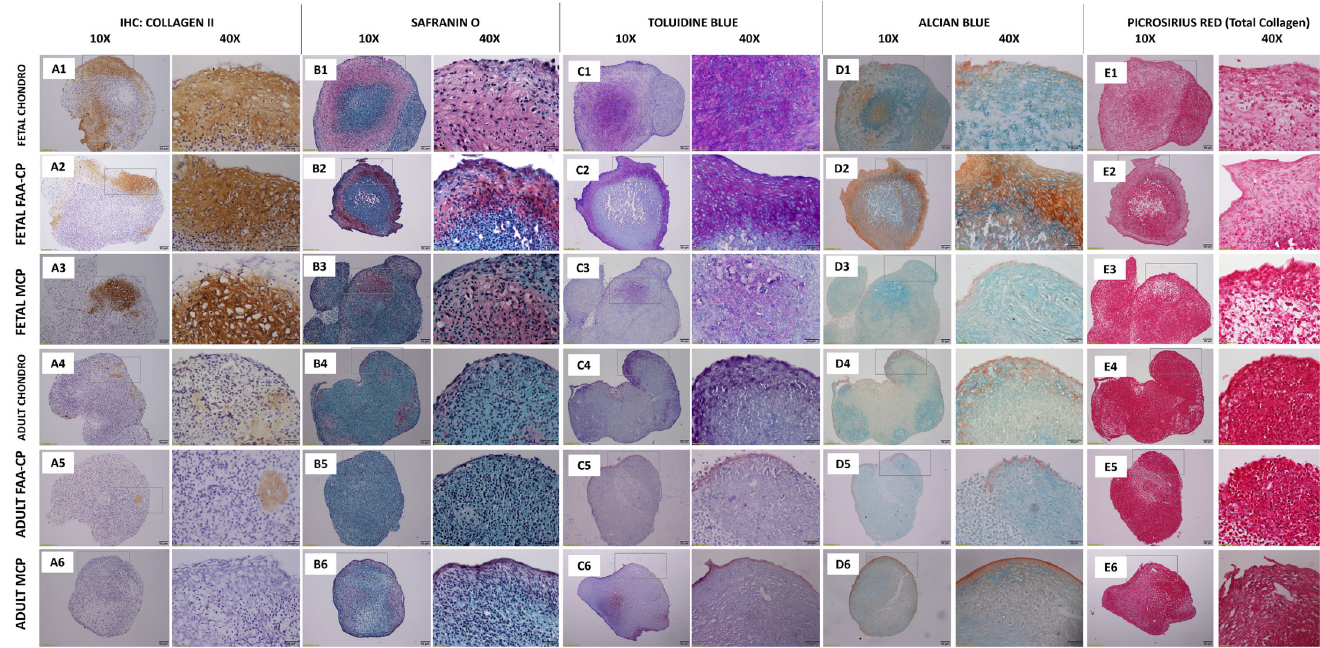
Fig 7. Representative images of chondrogenic differentiated pellets of the six groups: Fetal and Adult Chondrocytes, FAA-CPCs and MCPs. The formed pellets (1x106) were grown in StemPro chondrogenic medium for a period of 21 days. Greater uptake of Collagen type II (A1-A3), Safranin O (B1-B3), Toluidine blue (C1-C3) was observed with the Fetal cartilage derived cells when compared to their adult counterparts. All groups displayed comparable Alcian Blue and Picrosirius red uptake: Total collagen content Magnification: Scale bar (50 μ m or 20 μ m).